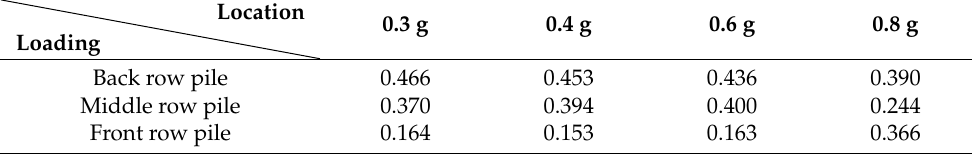
Table 5. The earth pressure sharing ratio of each row of piles (shaking table test).